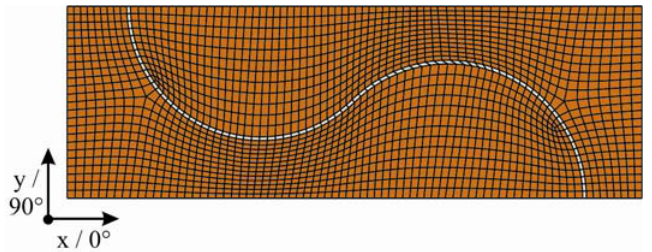
Figure 4. FE-mesh used for the two-dimensional preliminary design.